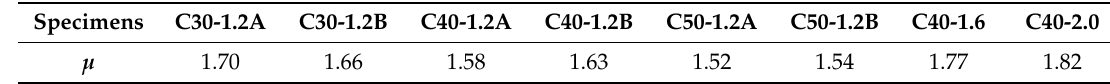
Table 5. The ductility coefficient ( µ ) of the tested columns.